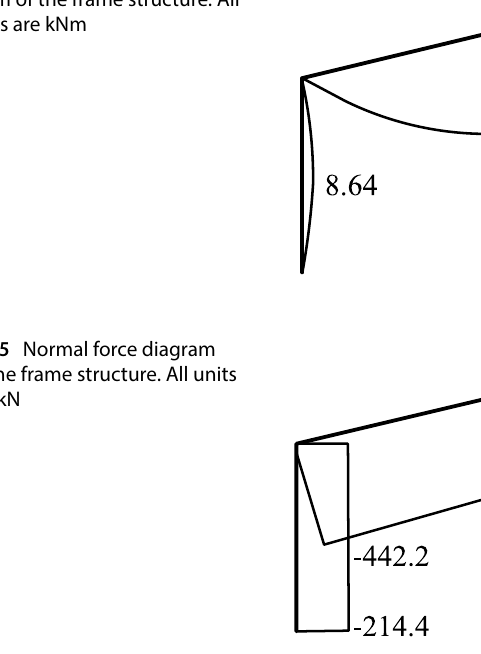
Fig. 4 Bending moment dia- gram of the frame structure. All units are kNm